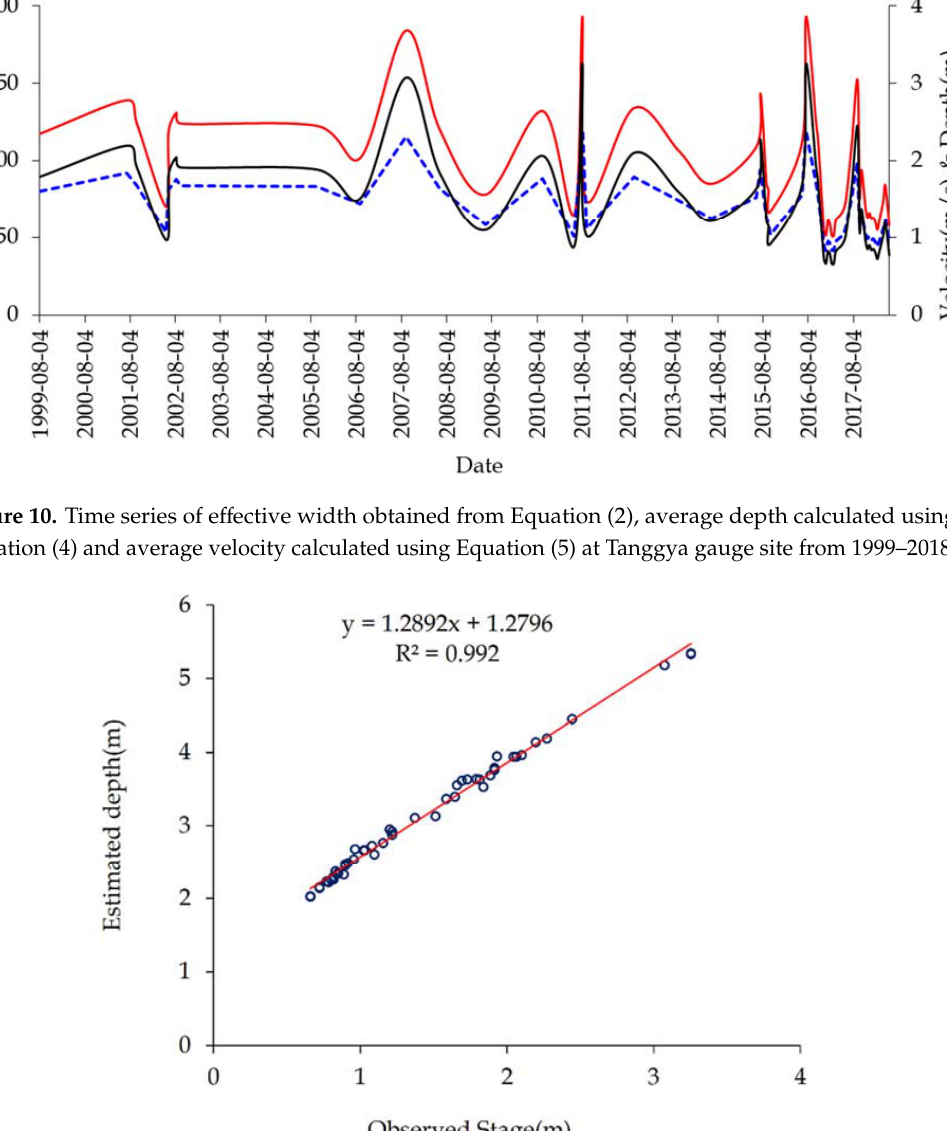
Figure 11. The scatterplots of observed stage and estimated average depth (using Equation (4)) at Tanggya gauging station for further validation of the methodology shows a very good correlation demonstrating the accuracy of our average depth estimation methodology especially in data scarce river basins.